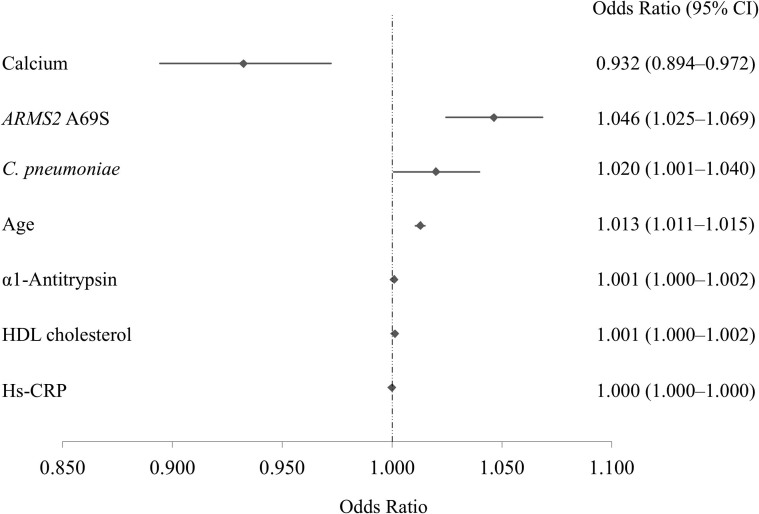
The relative strength of the significant factors for large drusen that showed a significant association in the final multivariate analysis.Serum calcium level had the strongest effect on the development of large drusen; the other factors were ARMS2 A69S (rs10490924) genotype, Chlamydia
pneumoniae IgG, and age. High-density lipoprotein (HDL) cholesterol, α1-antitrypsin, and high-sensitivity C-reactive protein (hs-CRP) had limited effect on disease development with odds ratio between 1.000 and 1.001. A diamond represents the point estimate of odds ratio for each factor with a horizontal line of the 95% confidence interval (CI).